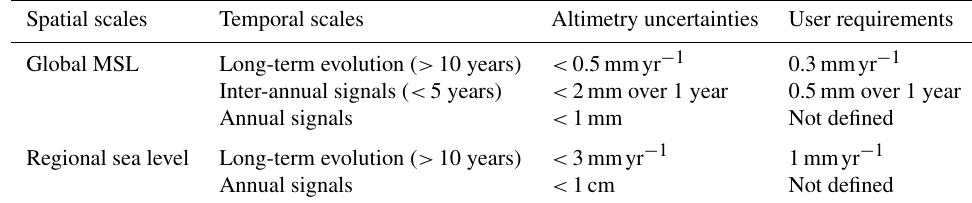
Table 3. Mean sea level error budget for the main climate scales (Ablain et al., 2015). User requirements are from GCOS (2011).